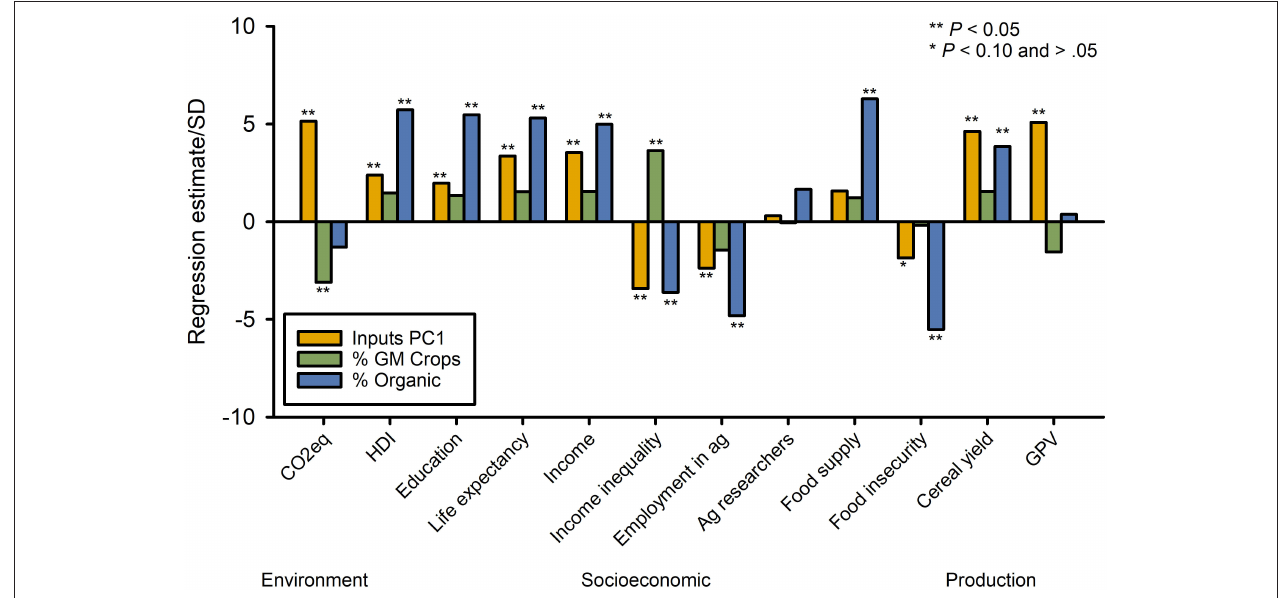
FIGURE 3 | Strength of relationship between sustainability indicators and agricultural practices. The figure displays coefficient estimates divided by the standard deviation from 95th quantile regressions for inputs PC1, percentage of cropland in GM crops, and percentage of agriculture in organic production for 12 metrics of environmental, economic, social, and food and nutrition sustainability (see Supplementary Table S1 for full metric details and Supplementary Table S8 for statistics). ** P < 0.05, * P <